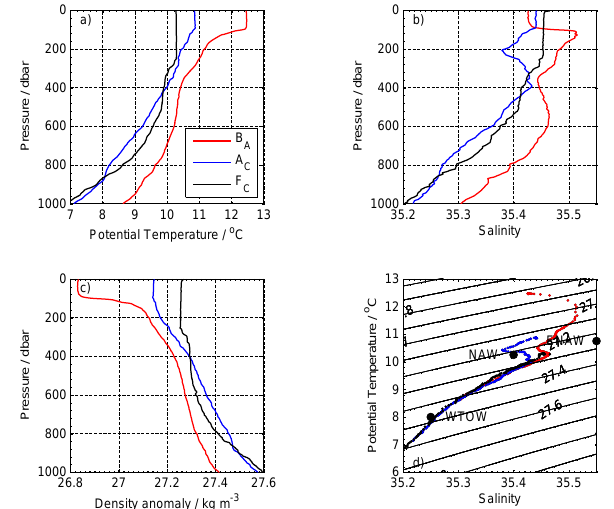
Figure 10. (a) Temperature, (b) salinity and (c) density anomaly profiles from the edge of cyclonic eddies B A , A C and F C (see Fig. 7). (d) Equivalent θS profiles.